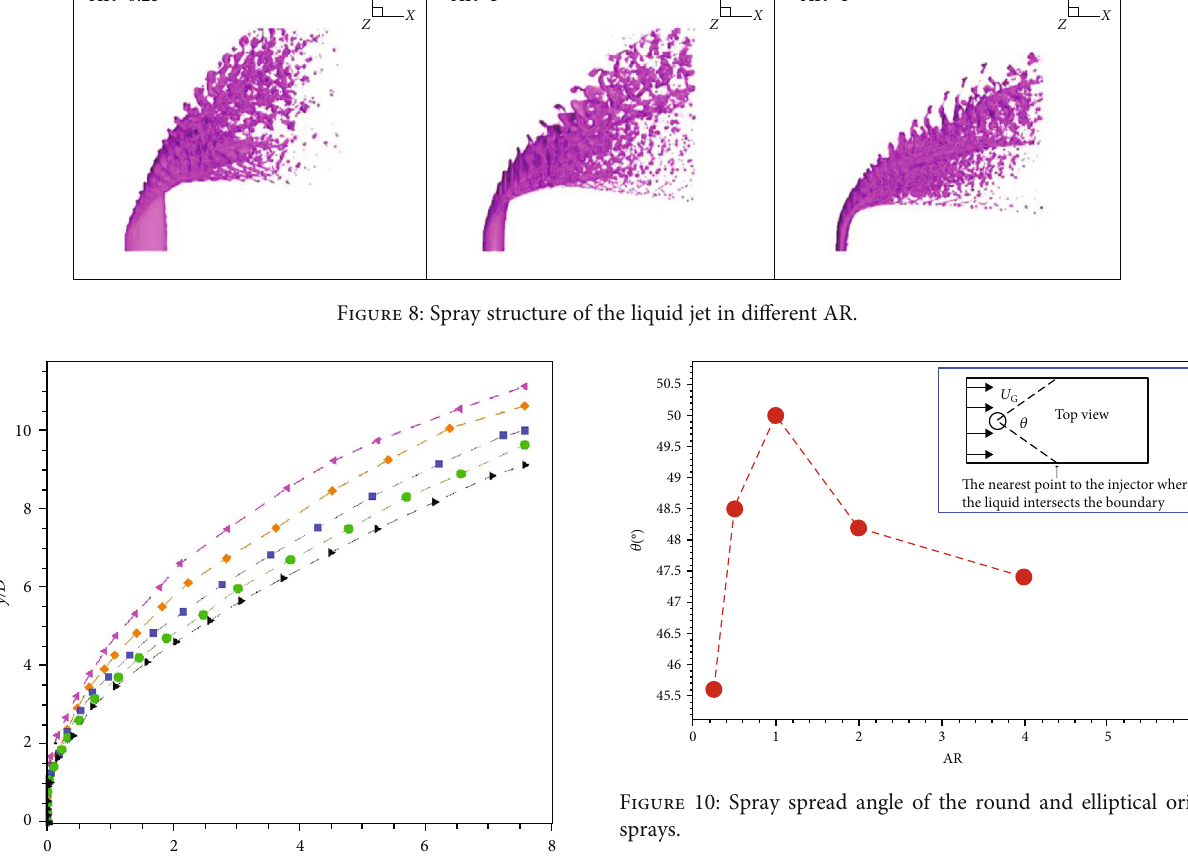
Figure 9: Penetration depth of the liquid jet at di ff erent AR.